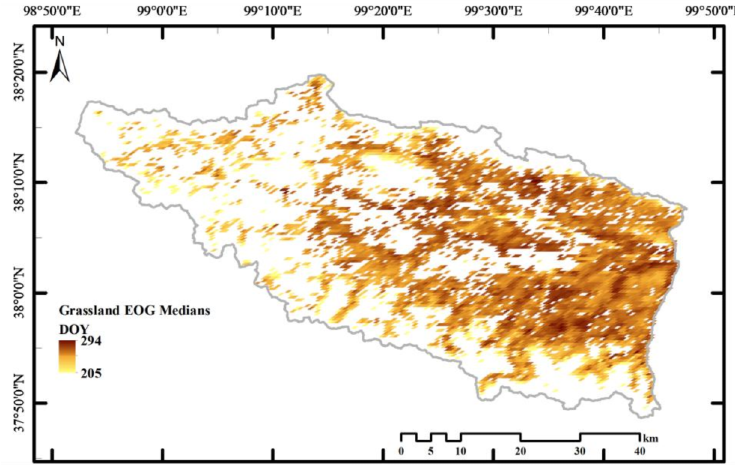
Figure 10. EOG average in the Muli region from 2014 to 2021.